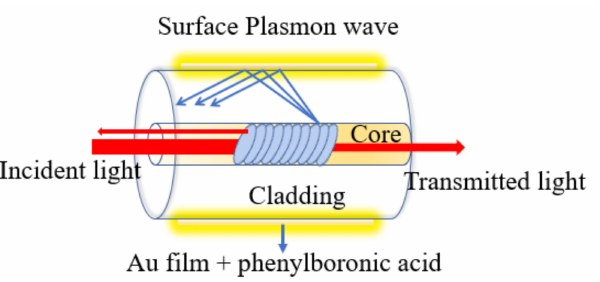
Figure 3. Schematic diagram of the working principle of a titled fiber grating